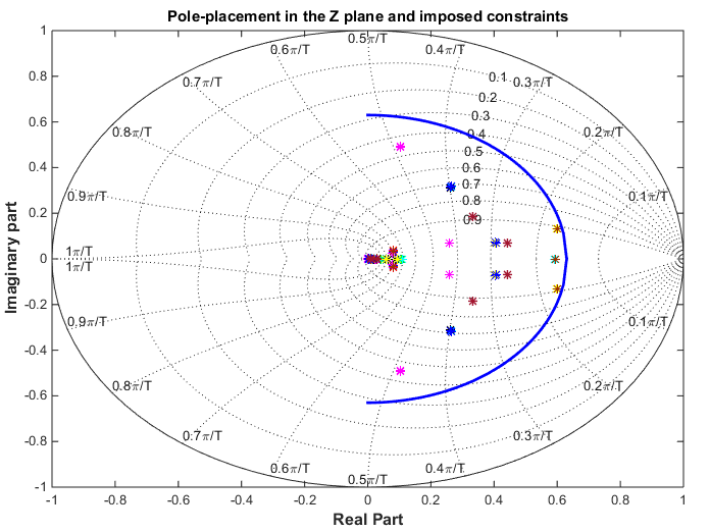
Figure 9. Result of the pole clustering for the